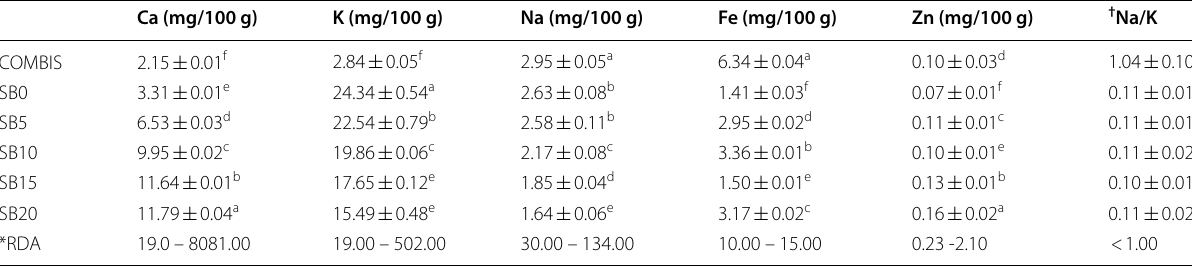
Values are expressed as mean SD ( n 3). Values with different letters down the columns are significantly different at p < 0.05. ± = † Calculated values. COMBIS: Commercial onion biscuit; SB0: 100% Plantain biscuit, SB5: 95% Plantain SB15: 85% Plantain 15% Shallot biscuit, SB20: 80% Plantain 20% Shallot biscuit. + + *RDA Recommended Dietary Allowance (Suitor and Murphy 2013; WHO =